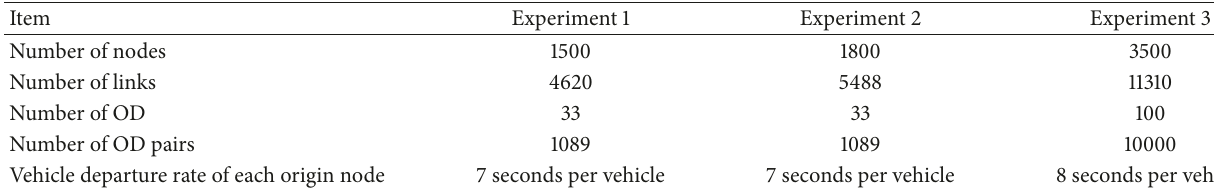
Table 1: Data of experiments.